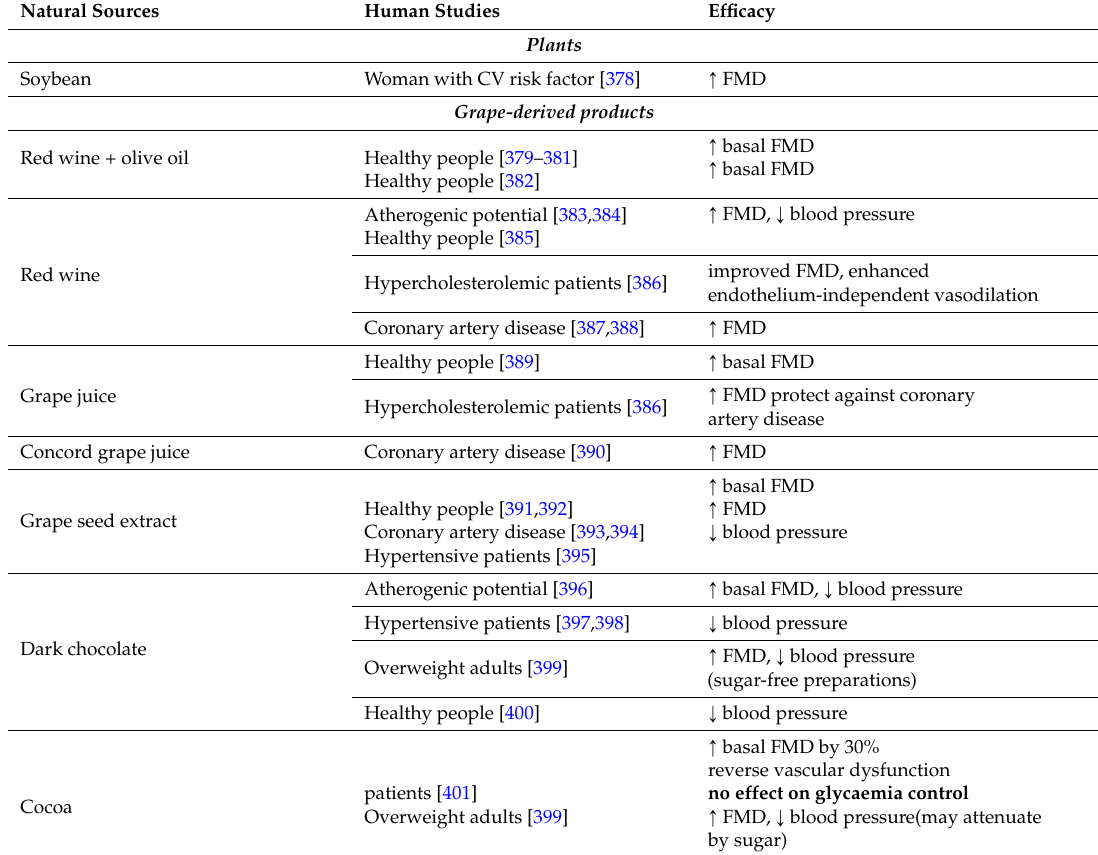
Table 5. Beneficial effects of several polyphenol-rich natural sources on vessels in